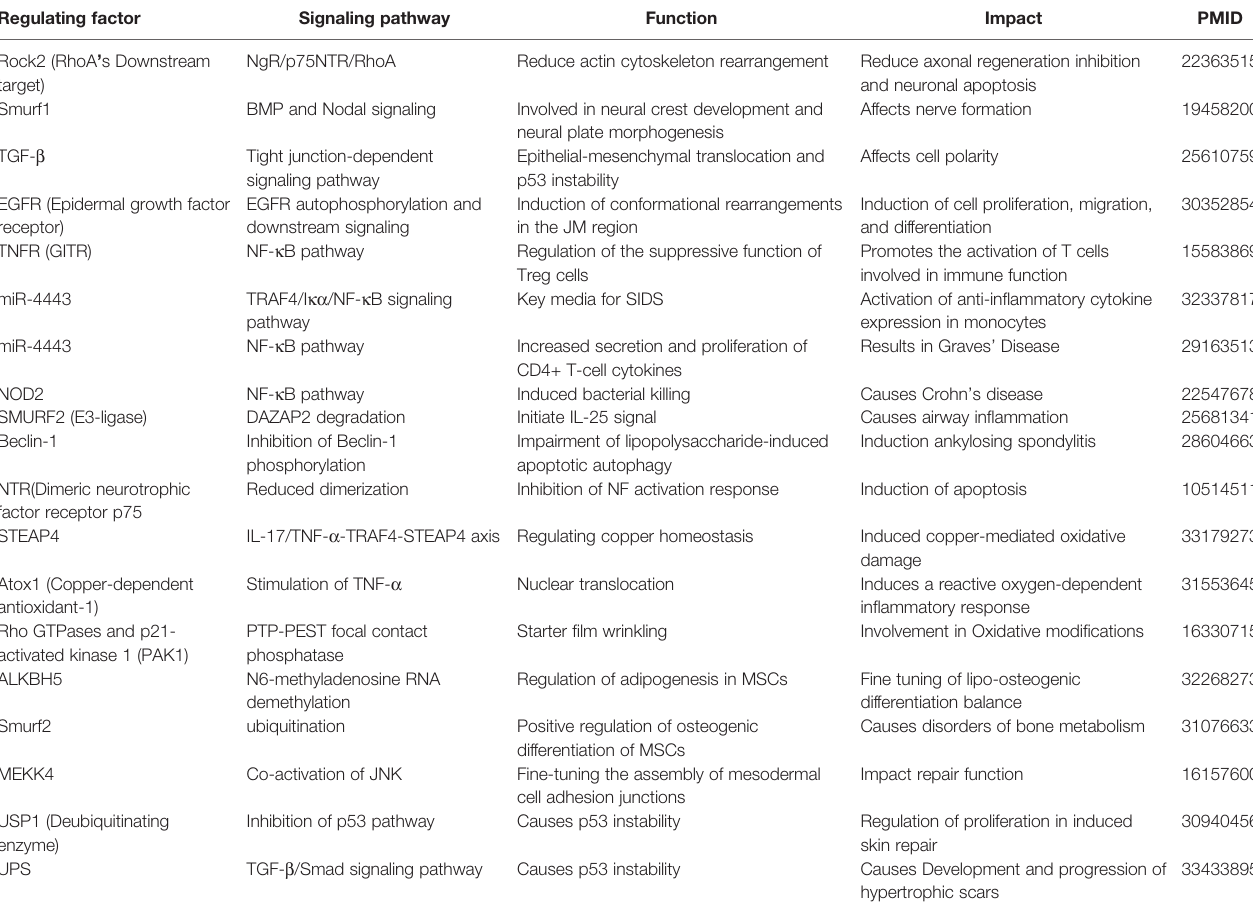
TABLE 1 | Physiological regulation of